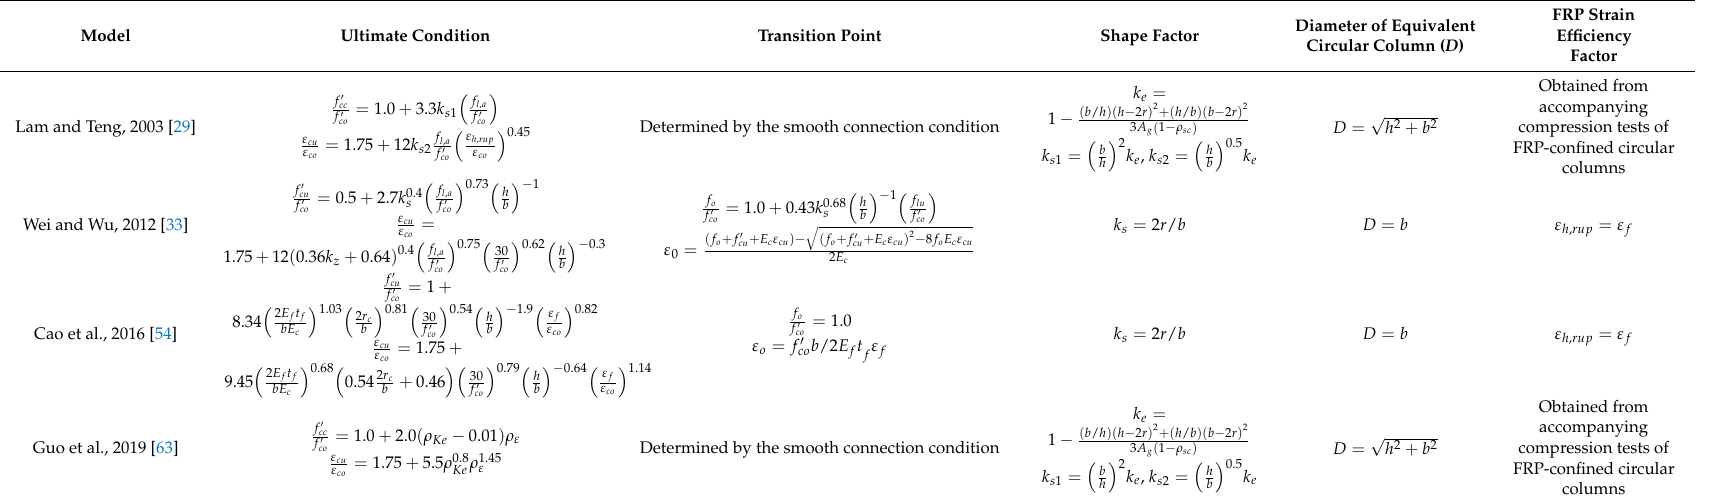
Table 4. Summary of existing stress–strain models for concrete in FRP-confined square